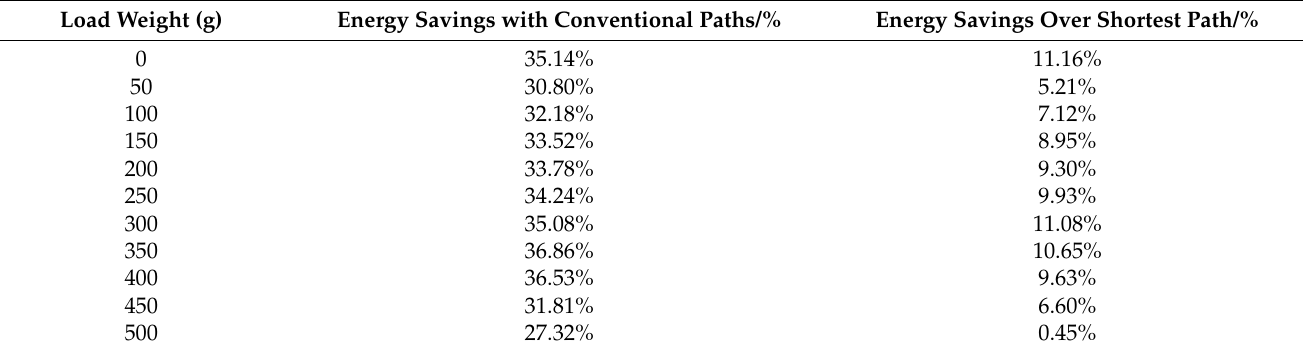
Table 4. Comparison of energy consumption of optimal path and other